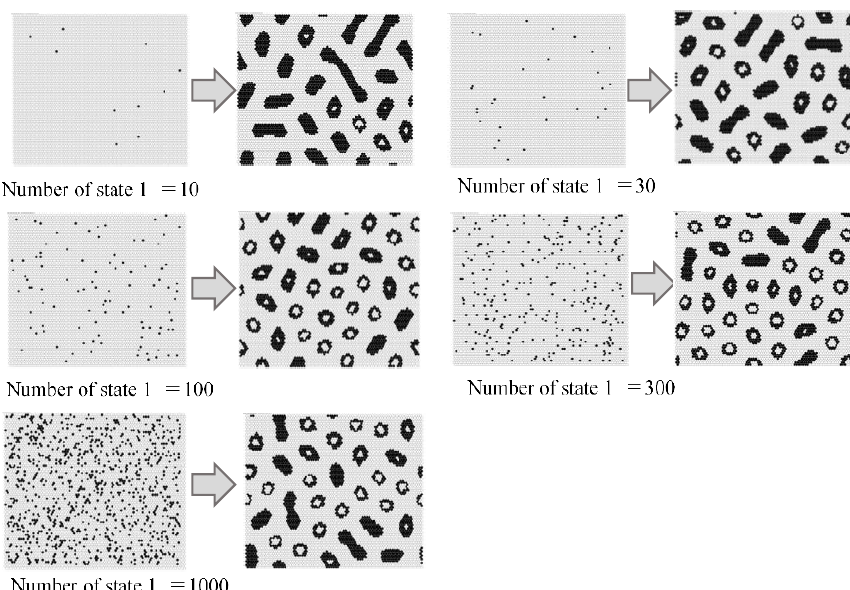
Figure 9. Results when varying the number of states 1 (black cell) to place them randomly in the initial states. The calculation conditions were s = 5, t = 9, w 1 = 0.40, and w 2 = 0.80 in a hexagonal grid. Based on this result, if there are more than a certain number of states 1, it is evident that a similar pattern formation develops.